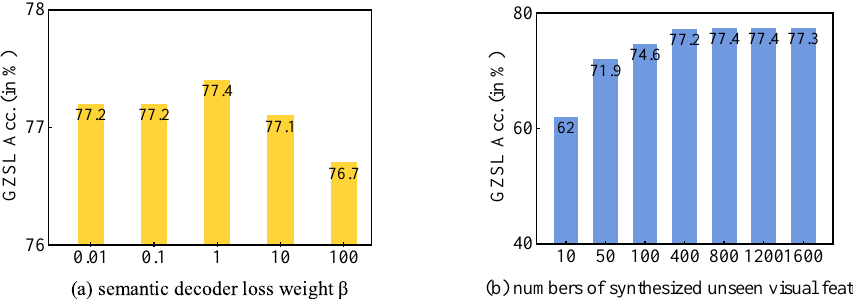
Figure 5. The effect of hyper-parameters L R weight β and the number of synthesized unseen visual features.